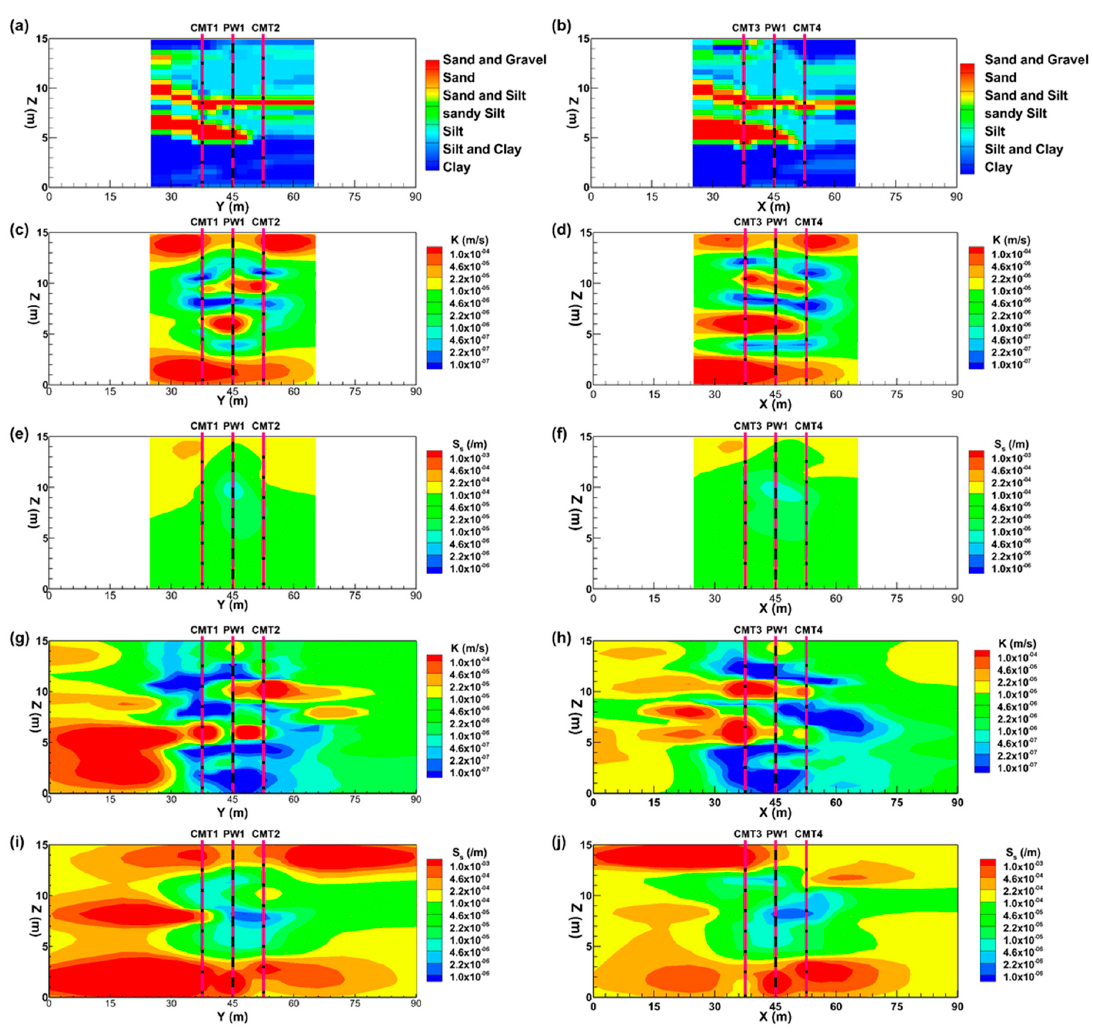
Figure 8. Comparison of stratigraphy map and the K and S s tomograms: ( a ) stratigraphy section (CMT1 to CMT2); ( b ) stratigraphy section (CMT3 to CMT4); ( c ) K tomogram section (CMT1 to CMT2) from Berg and Illman [18]; ( d ) K tomogram section (CMT3 to CMT4) from Berg and Illman [18]; ( e ) S s tomogram section (CMT1 to CMT2) from Berg and Illman [18]; ( f ) S s tomogram section (CMT3 to CMT4) from Berg and Illman [18]; ( g ) K tomogram section (CMT1 to CMT2) from THT using 14 tests; ( h ) K tomogram section (CMT3 to CMT4) from THT using 14 tests; ( i ) S s tomogram section (CMT1 to CMT2) from THT using 14 tests; and ( j ) S s tomogram section (CMT3 to CMT4) from THT using 14 tests.